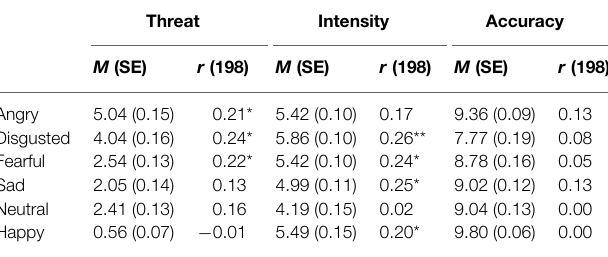
TABLE 1 | Descriptive statistics for threat, intensity and accuracy for each emotion and zero-order correlations with empathy